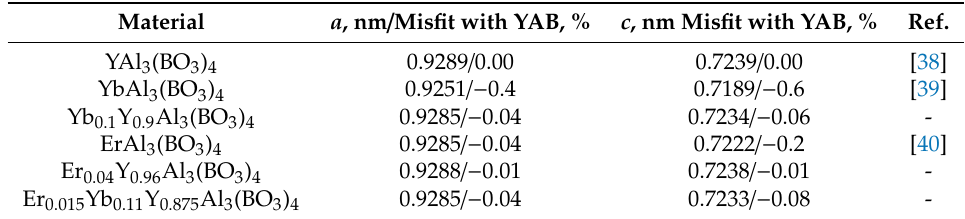
Table 1. Lattice parameters of pure YAl-, YbAl- and ErAl-borates, R-doped YAl 3 (BO 3 ) 4 epitaxial layers and their lattice misfit with YAB at room